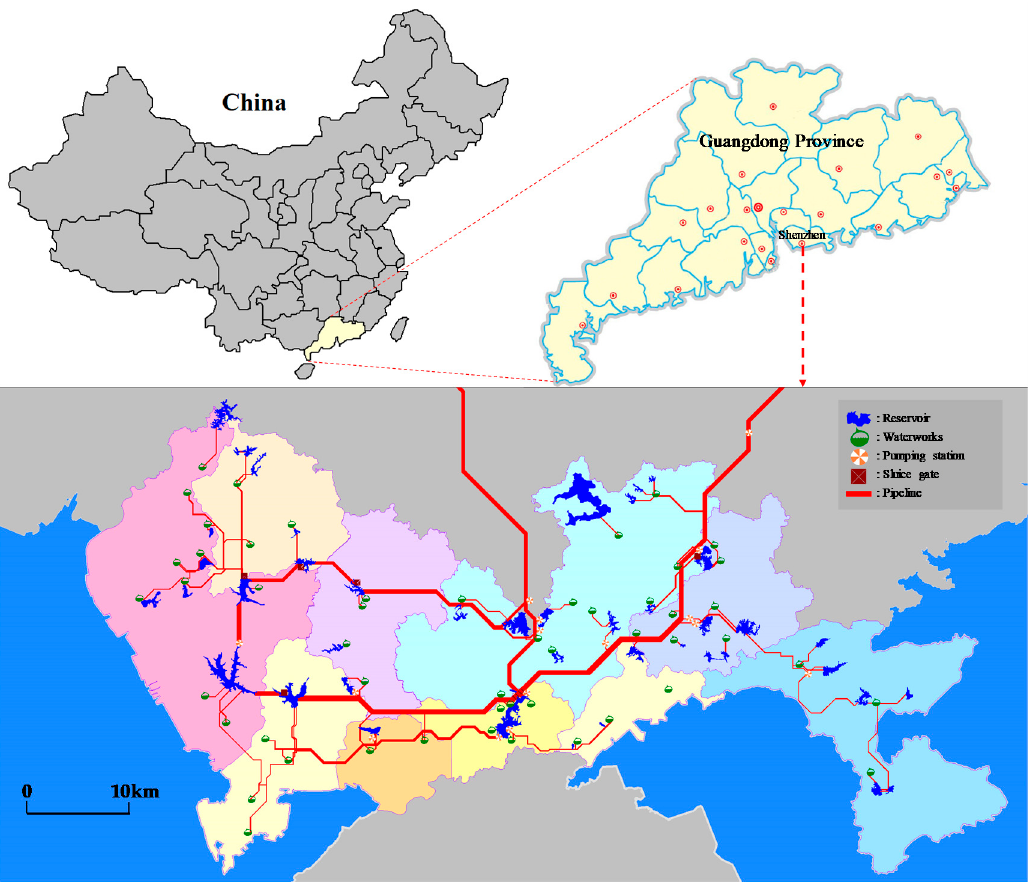
Figure 1. The distribution of the actual reservoirs, waterworks, pumping stations, gates and water supply pipelines in Shenzhen City.